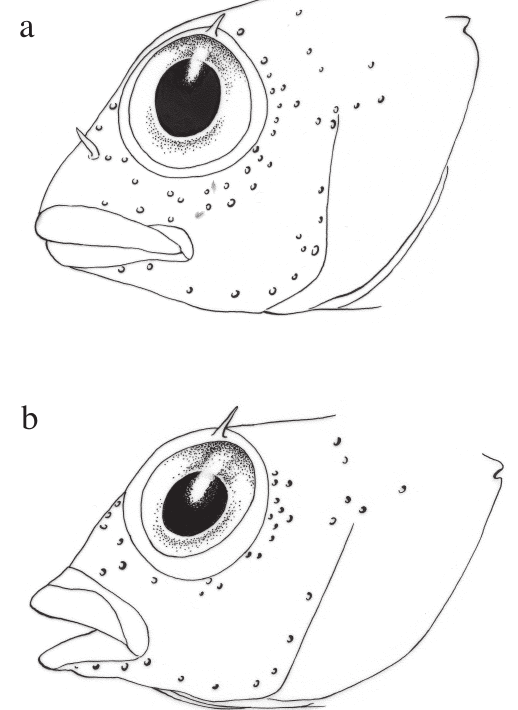
F IG . 3. – Variation in the cephalic pore system between T. tartes- sicum (a, female 55 mm from SP9) and T. tripteronotus (b, female 58 mm from